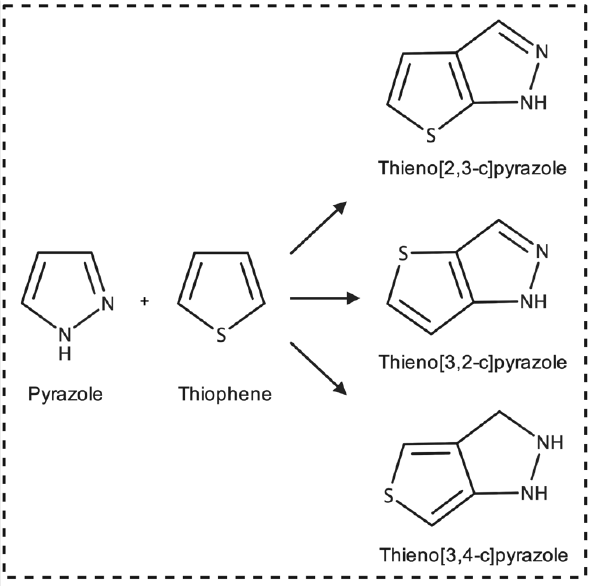
Figure 1. Chemical structures of pyrazole, thiophene, and thienopyrazoles.